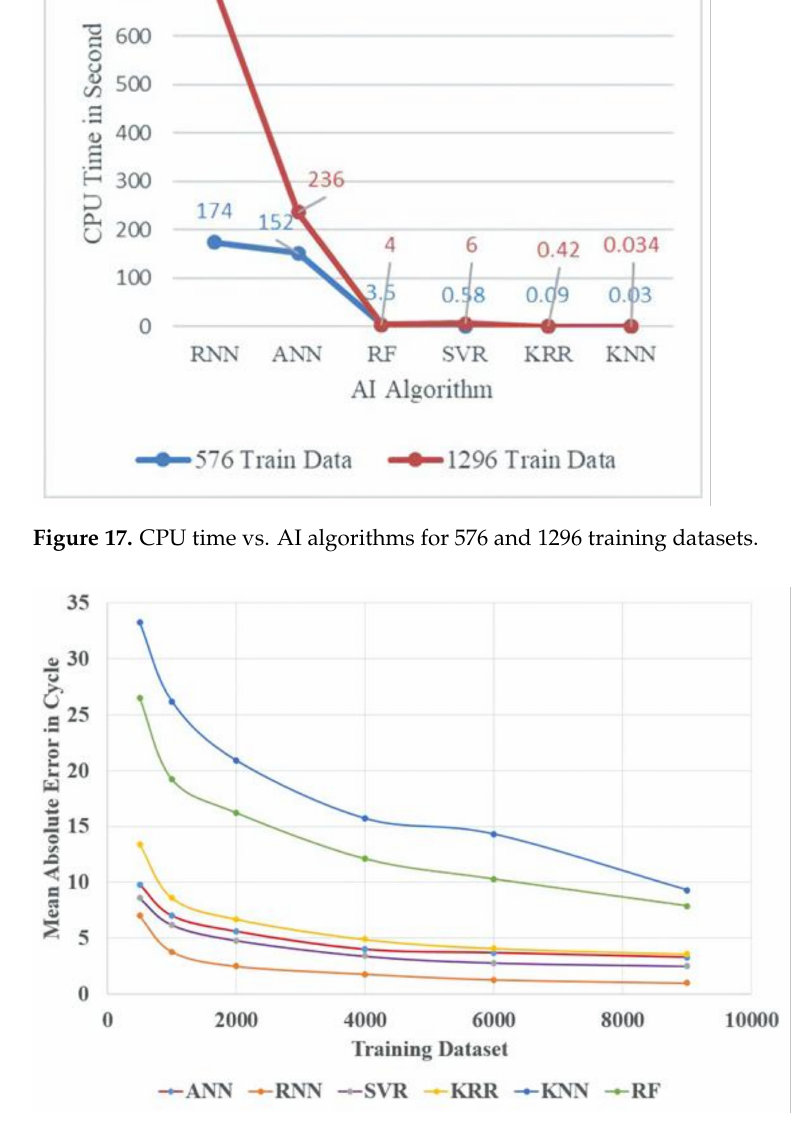
Figure 18. Mean absolute error vs. training dataset for different AI